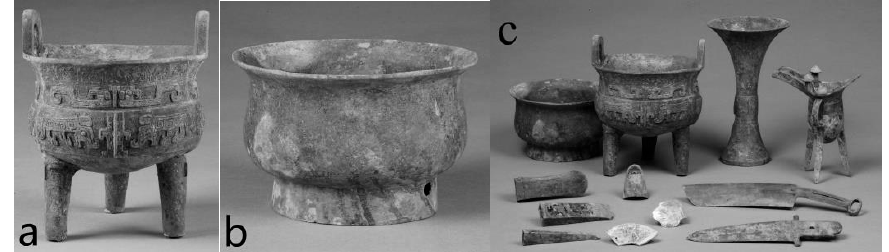
Figure 1. Bronze ritual vessels discovered in tomb M22 of Xiaohucun site ( a = Ding, b = Gui, c = All bronze grave goods).